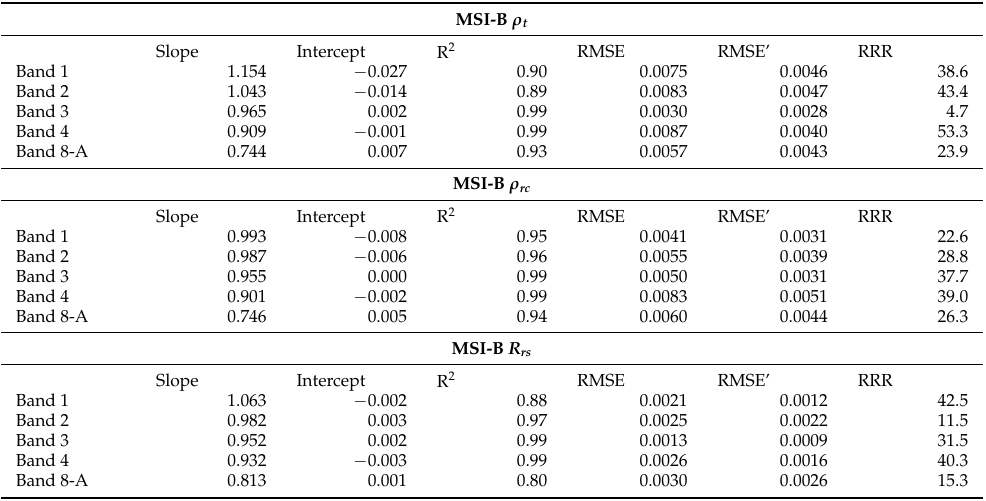
Table 7. Statistical parameters of linear regression, RMSE before and after band adjustment for test data and the RMSE reduction rate (RRR) considering the OLI and MSI-B